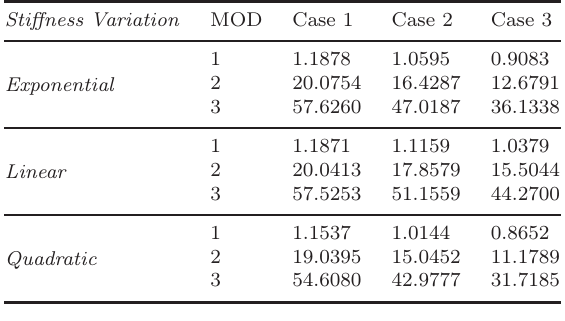
Table 2. Normalized buckling loads for first three modes for the columns with variable flexural stiffness ( a/L = 0 . 8) .